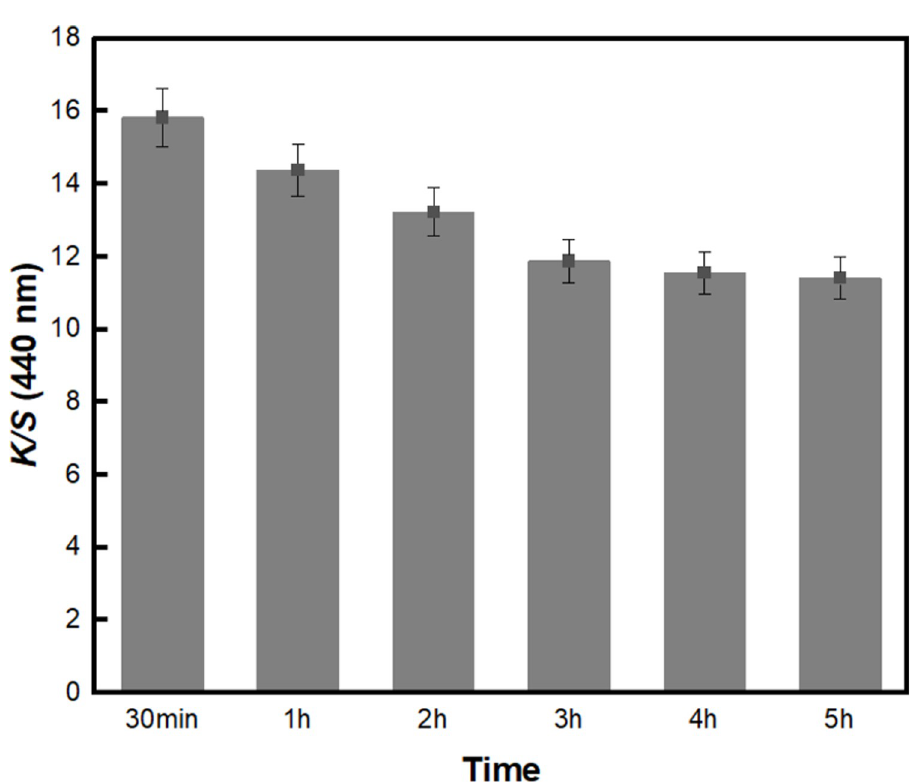
Fig 3. The K/S values of BC-COF bio-leather at 440 nm with varied dyeing time from 30 min to 5 h (Extraction conditions: Liquor ratio of 1:10 (w/v), coffee at an amount of 200 wt% BC, 90˚C, 1 h; dyeing conditions: Fabric-to- liquor ratio of 1:10 (w/v),